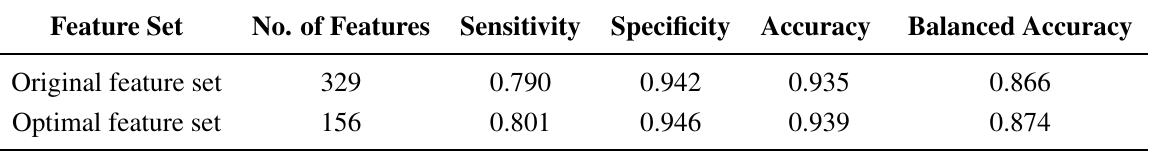
Table 1. Prediction results of the original feature set and the optimal feature